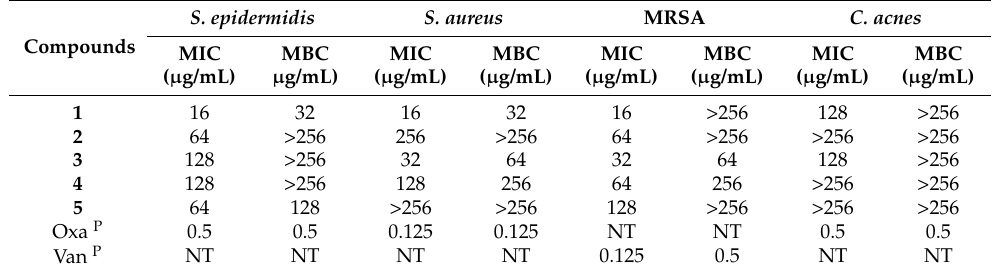
Table 1. MIC and MBC of the isolated compounds against S. epidermidis, S. aureus, MRSA and C. acnes .